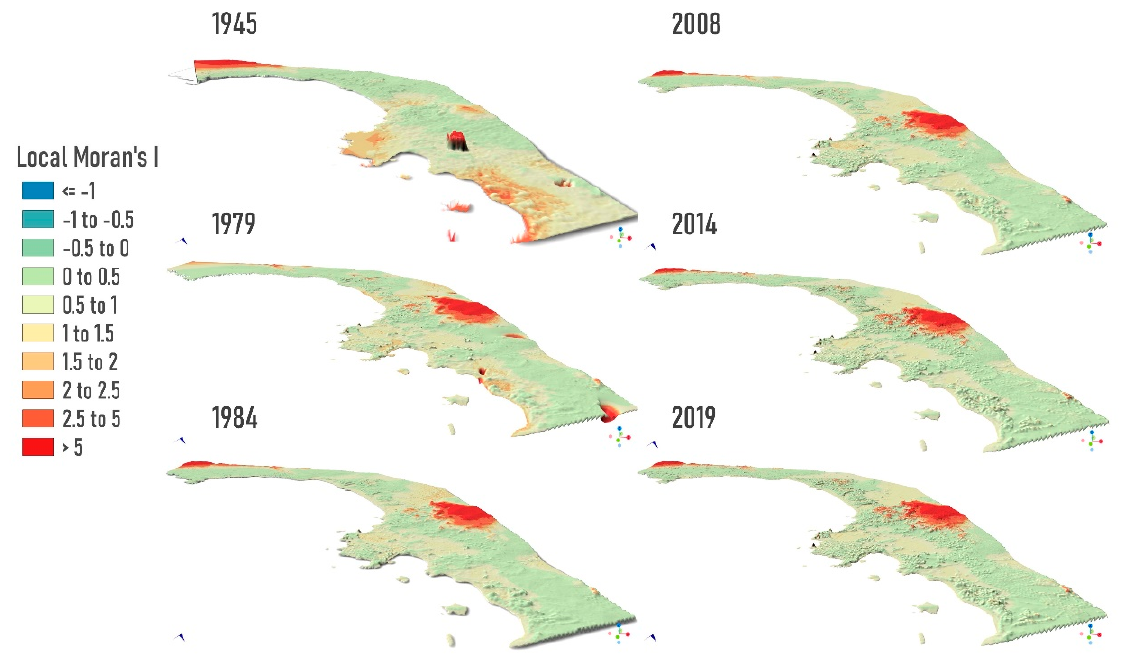
Figure 7. Spatial autocorrelation (Local Moran’s I) maps of the historical DSM series superimposed on the corresponding elevation values (vertical exaggeration ×3).